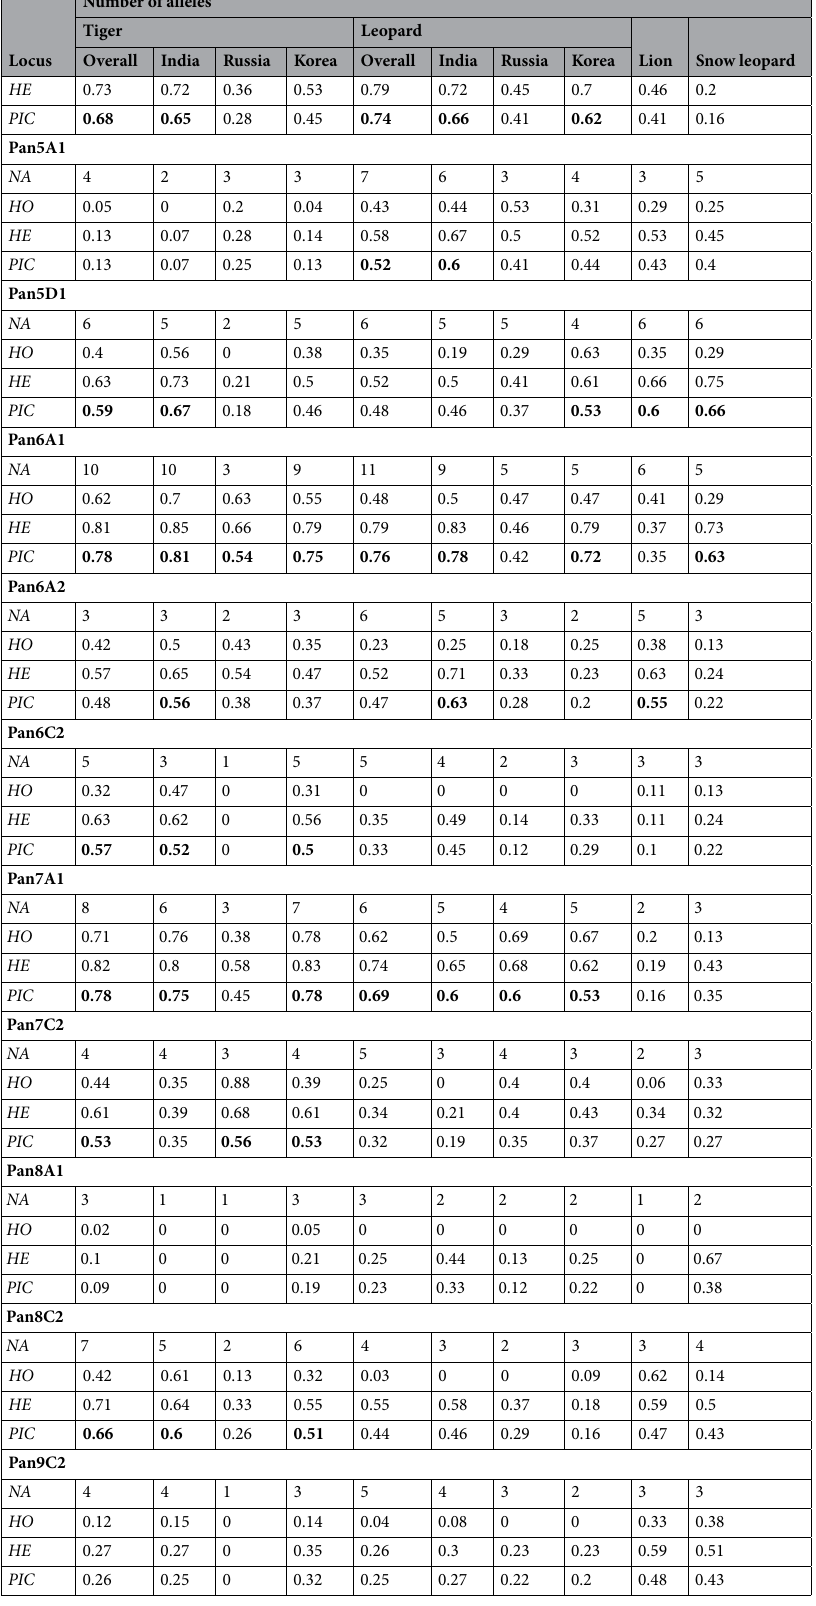
Table 2. Characterizationof 32 polymorphic microsatellite loci in four big cat species. NA Number of alleles, HO observed heterozygosity, HE expected heterozygosity, PIC Polymorphic Information Content (>0.5 -in